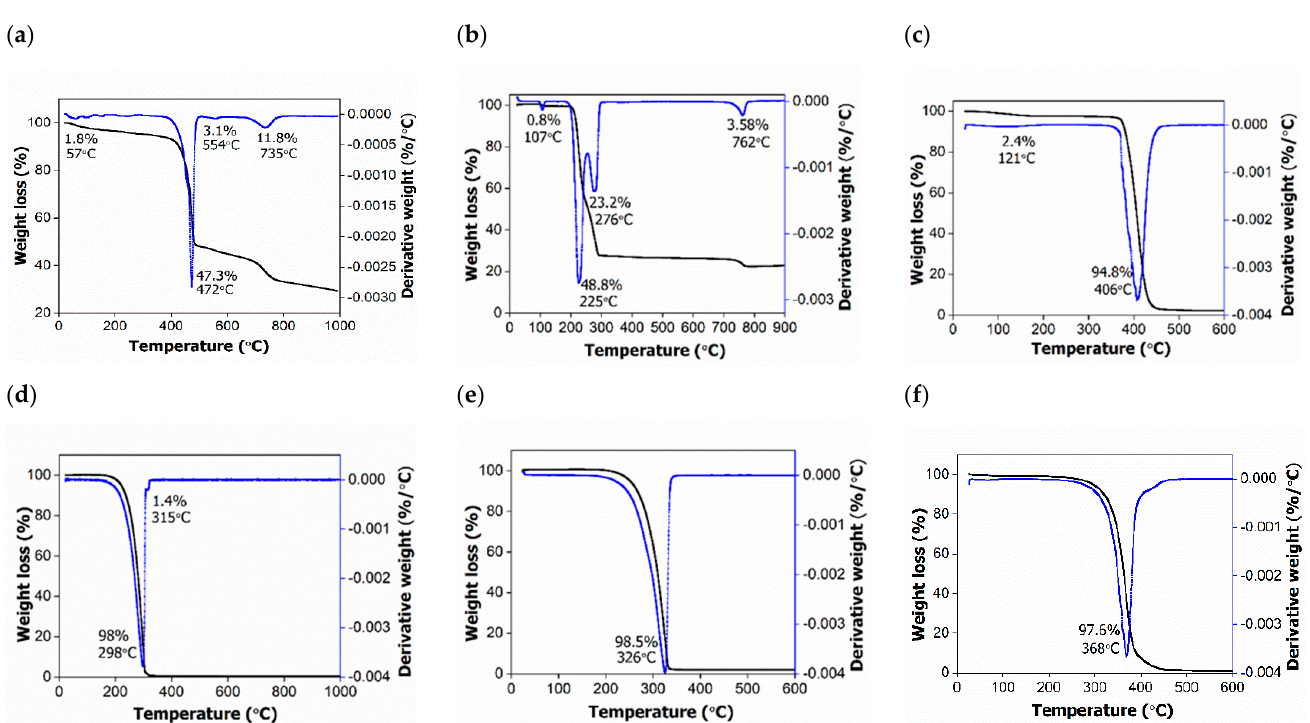
Figure 4. TGA/DTG thermograms of surfactants ( a ) SDBS; ( b ) SDS; ( c ) T80, and their hexaconazole-micelle nanodelivery systems: ( d ) HMBS; ( e ) HMDS; and ( f ) HMT.